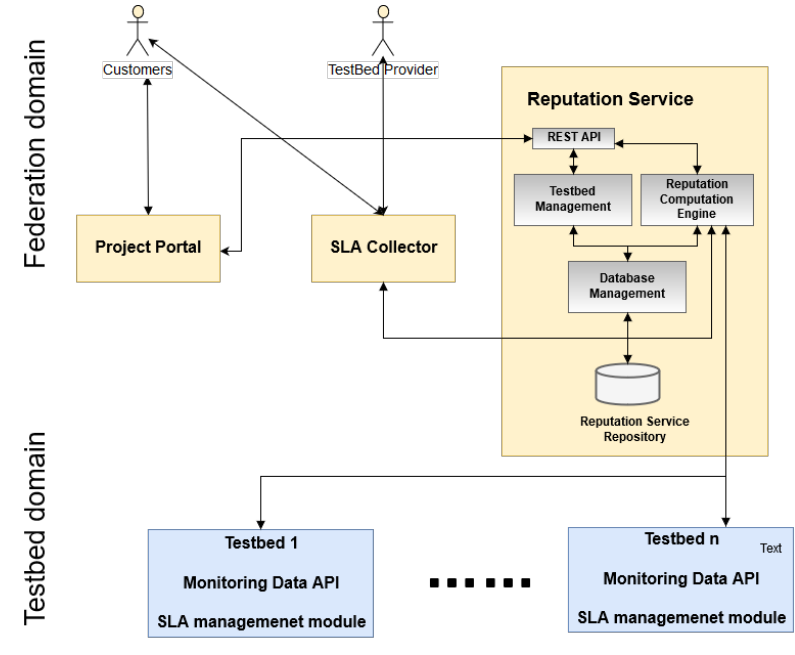
Figure 2. HELNET reputation